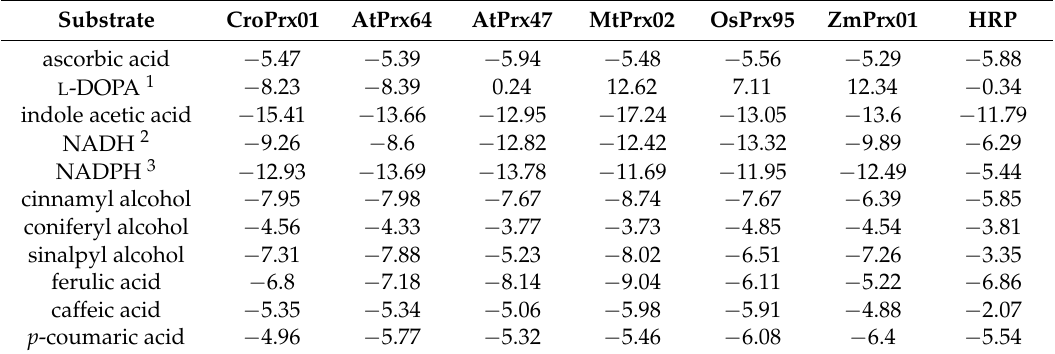
Table 2. Docking results of multiple ligand molecules by Firedock (http://bioinfo3d.cs.tau.ac.il/ FireDock/). Putative structures of the membrane-bound peroxidases CroPrx01 (5aog.1.A),